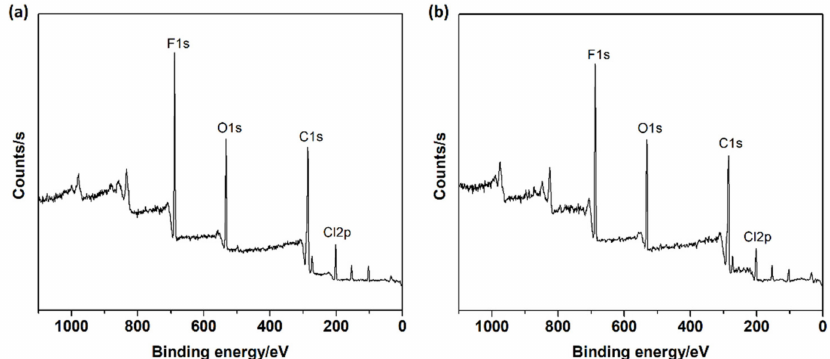
Figure 6. X-ray photoelectron spectroscopy (XPS) survey spectra of ( a ) the fluorinated polyurethane coating and ( b ) poly(CTFE-alt-BVE) coating (Sample P4).